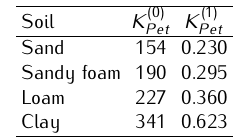
Table 1. Coefficients in Petri